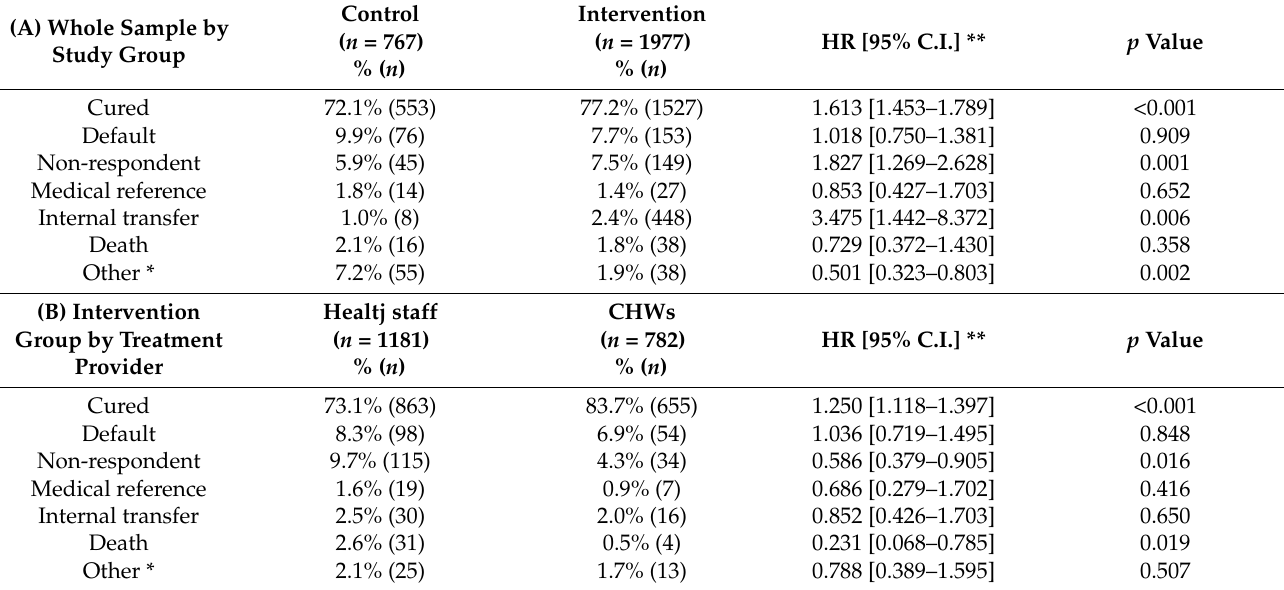
Table 4. Treatment outcomes of children with uncomplicated severe acute malnutrition by study group (A) and by treatment provider inside the intervention group (B).